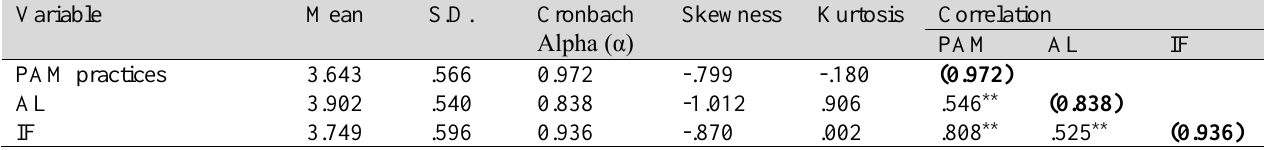
Intervariable correlation, arithmetic averages, and internal consistency coefficients of